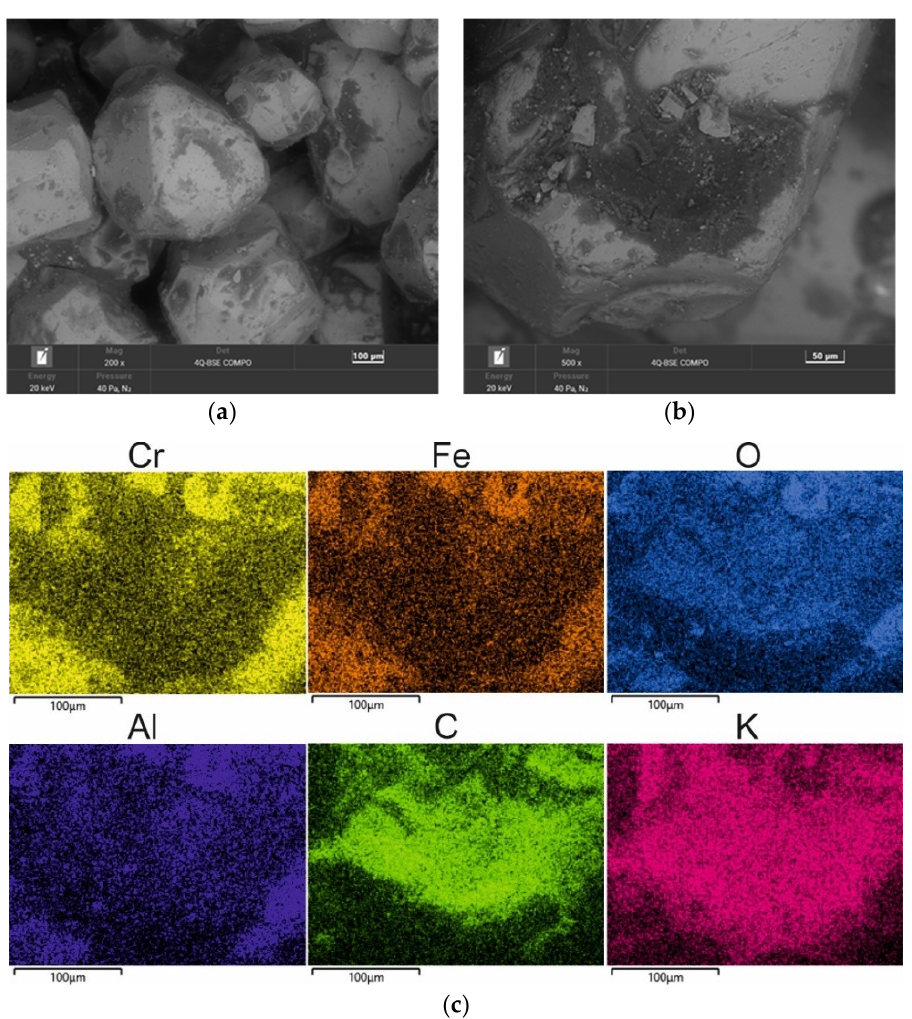
Figure 5. SEM image of spent sand SS: ( a ) mag. 200×; ( b ) mag. 1,000×; ( c ) EDS map of element distribution in the analysed area of spent sand SS.